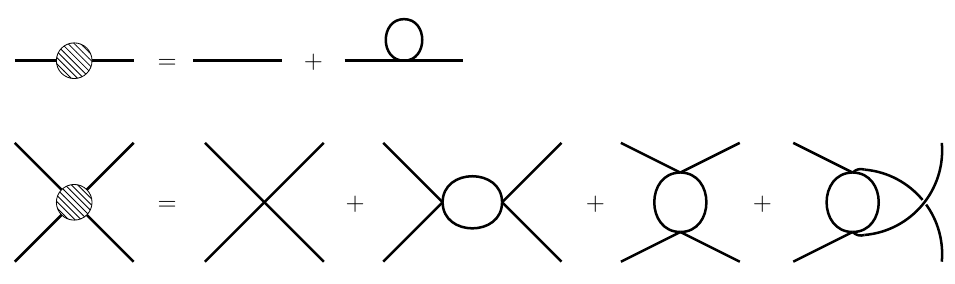
Figure 1 . Diagrammatic representation of the two- and four-point functions to one loop